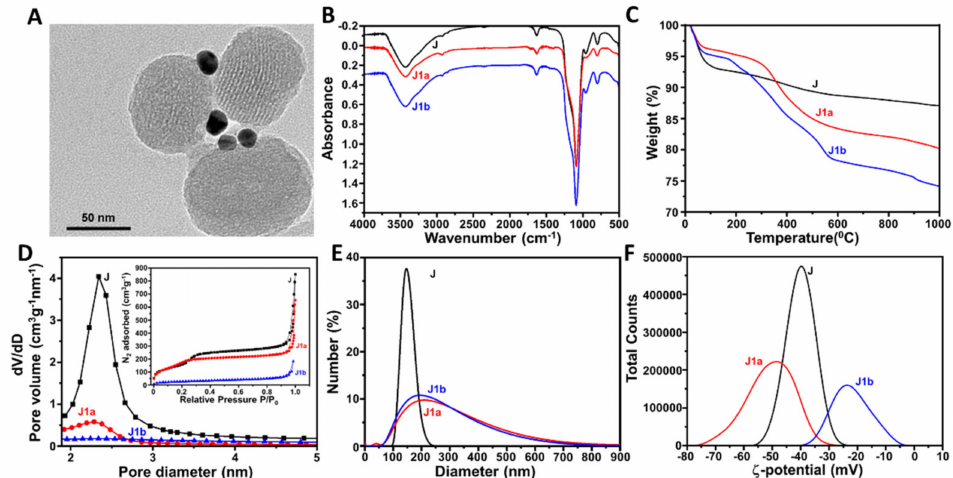
Figure 1. Characterization of the J1c nanodevice: ( A ) HR-TEM image of J. ( B ) Infrared spectra and ( C ) thermograms for the Janus Au-MS nanoparticles J, J1a, and J1b. ( D ) N 2 adsorption-desorption isotherms for J, J1a, and J1b (Inset: pore size distribution). ( E ) Hydrodynamic diameter and ( F ) Zeta potential of J, J1a, and